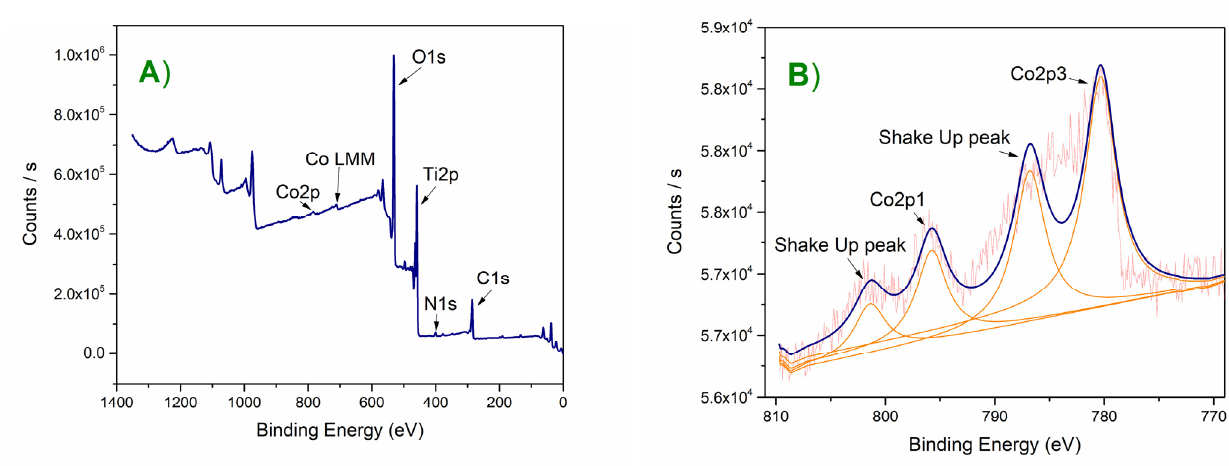
Figure 4. ( A ) Survey spectrum. It is almost identical for both samples. The Co-TiO 2 -NTs sample additionally reveals cobalt in the form of Co2p and Co LMM peaks; ( B ) detailed cobalt spectrum for Co-TiO 2 -NTs.